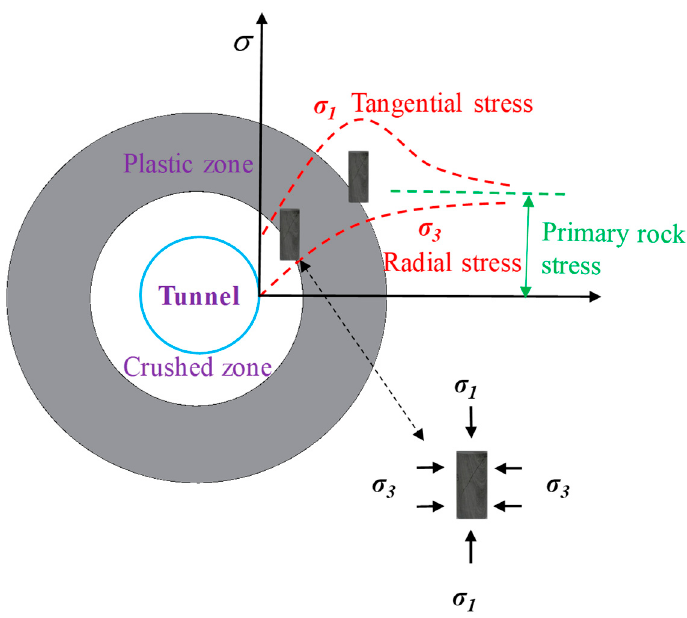
Figure 2. Redistribution of tunnel surrounding rock stress after excavation.